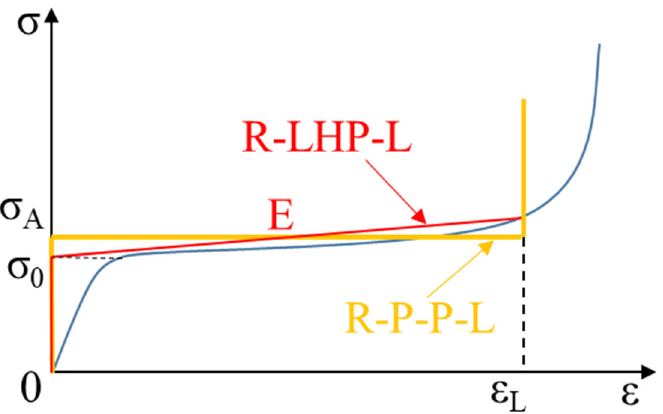
Figure 2. Diagram of the stress σ of foam materials as a function of the strain ε, the green line is R-P-P-L model and the red line is R-LHP-L model [42]. Here, σ 0 is the yield stress of the material, ε L is the locking strain of the material, E 1 is the hardening modulus of the material, and σ pl is the plateau stress.